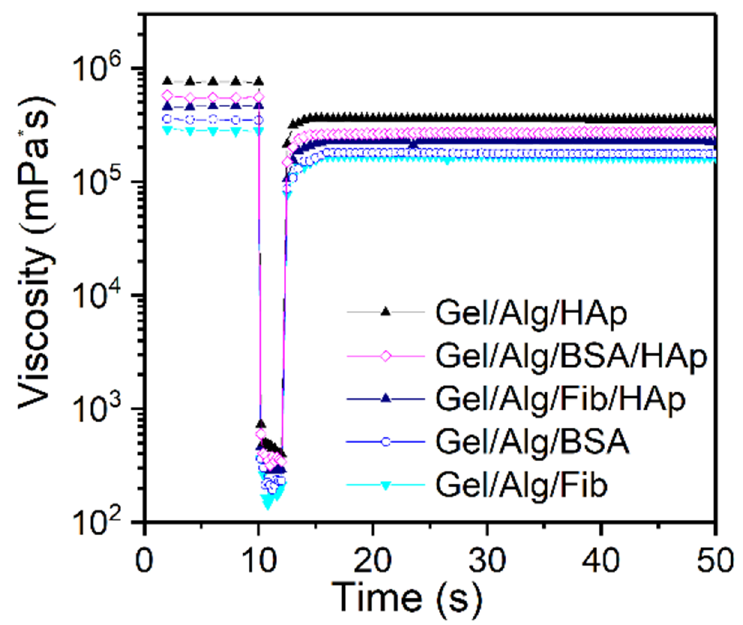
Figure 8. Three interval thixotropy (3-ITT) test.